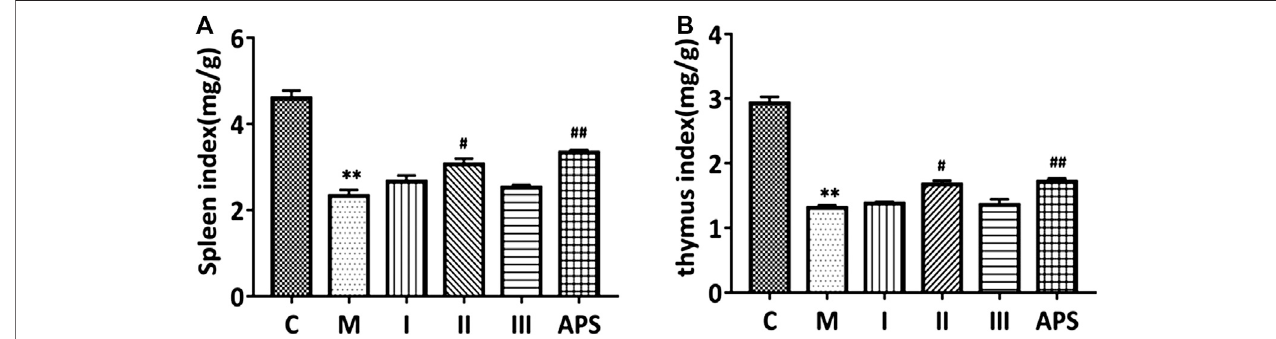
FIGURE 6 | Comparison of spleen (A) and thymus (B) indices between groups. C: control group, M: model group, I: APS-I, II: APS-II, III: APS-III. n (cid:2) 6, ± s , * p < 0.05, ** p < 0.01, *** p < 0.001 vs. the control group; # p < 0.05, ## p < 0.01, ### p < 0.001 vs. the model group.